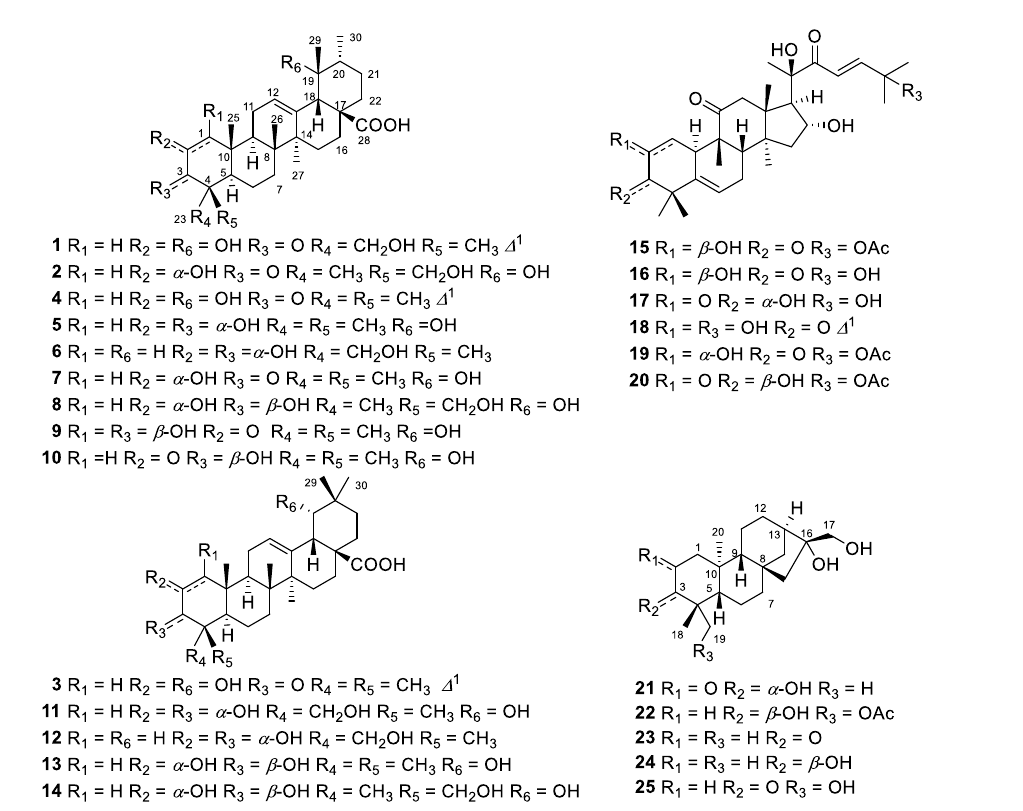
Figure 1. Chemical structure of triterpenoids ( 1 − 20 ) and diterpenoids ( 21 − 25 ).